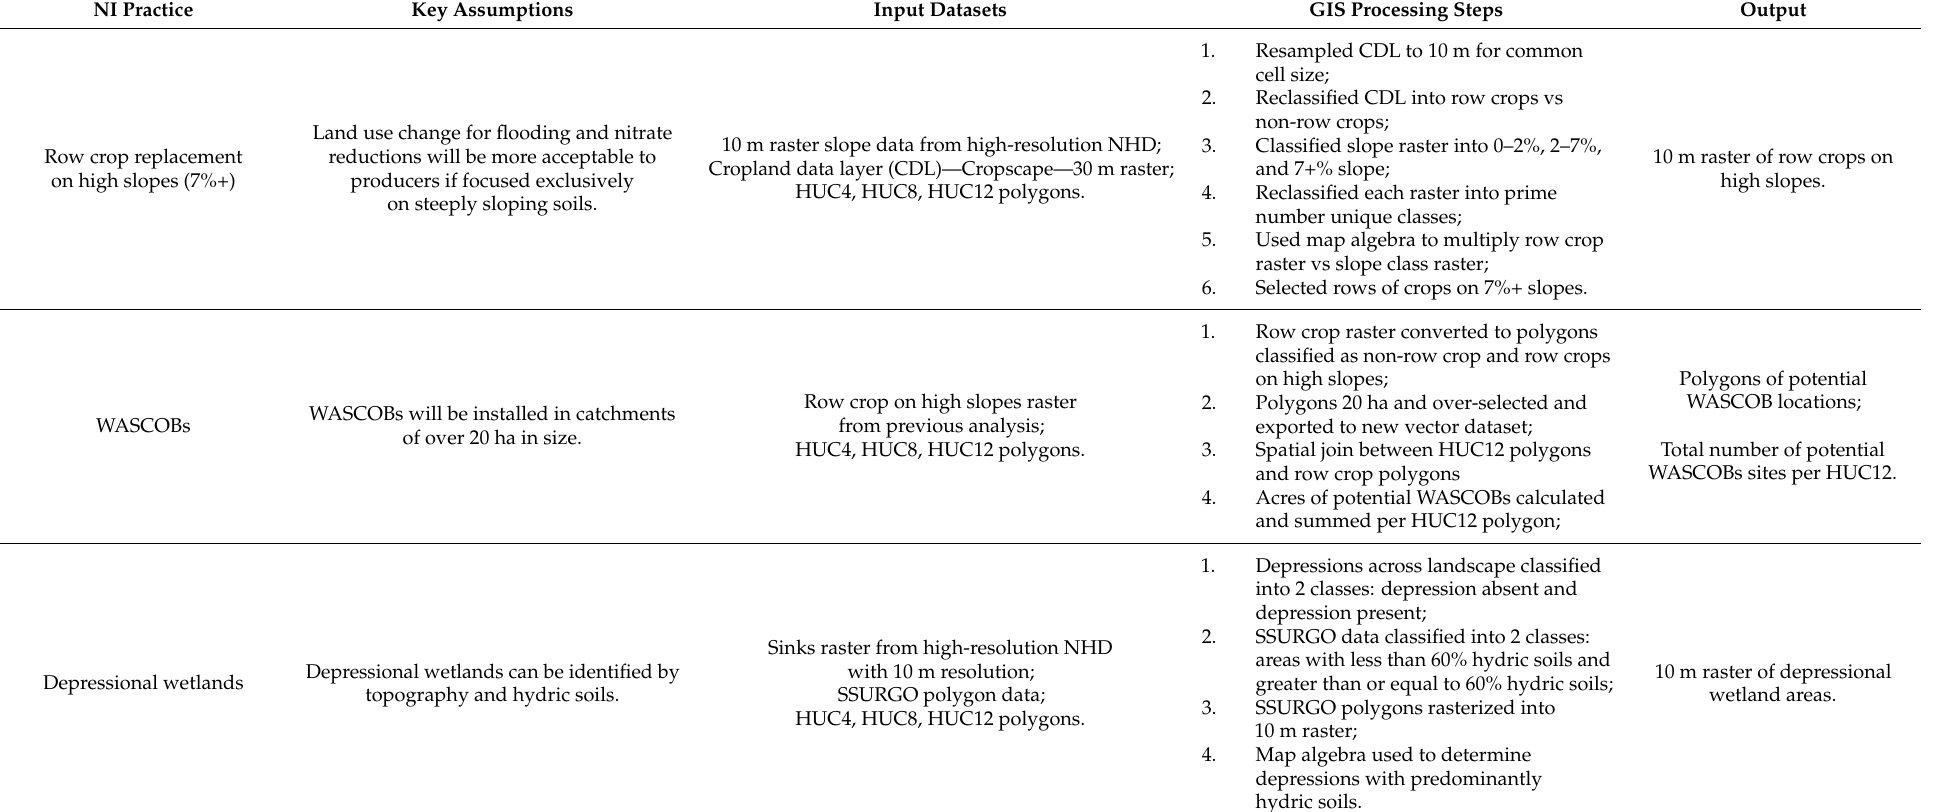
Table 1. Input data, GIS processing steps, and output for locating NI practices in the